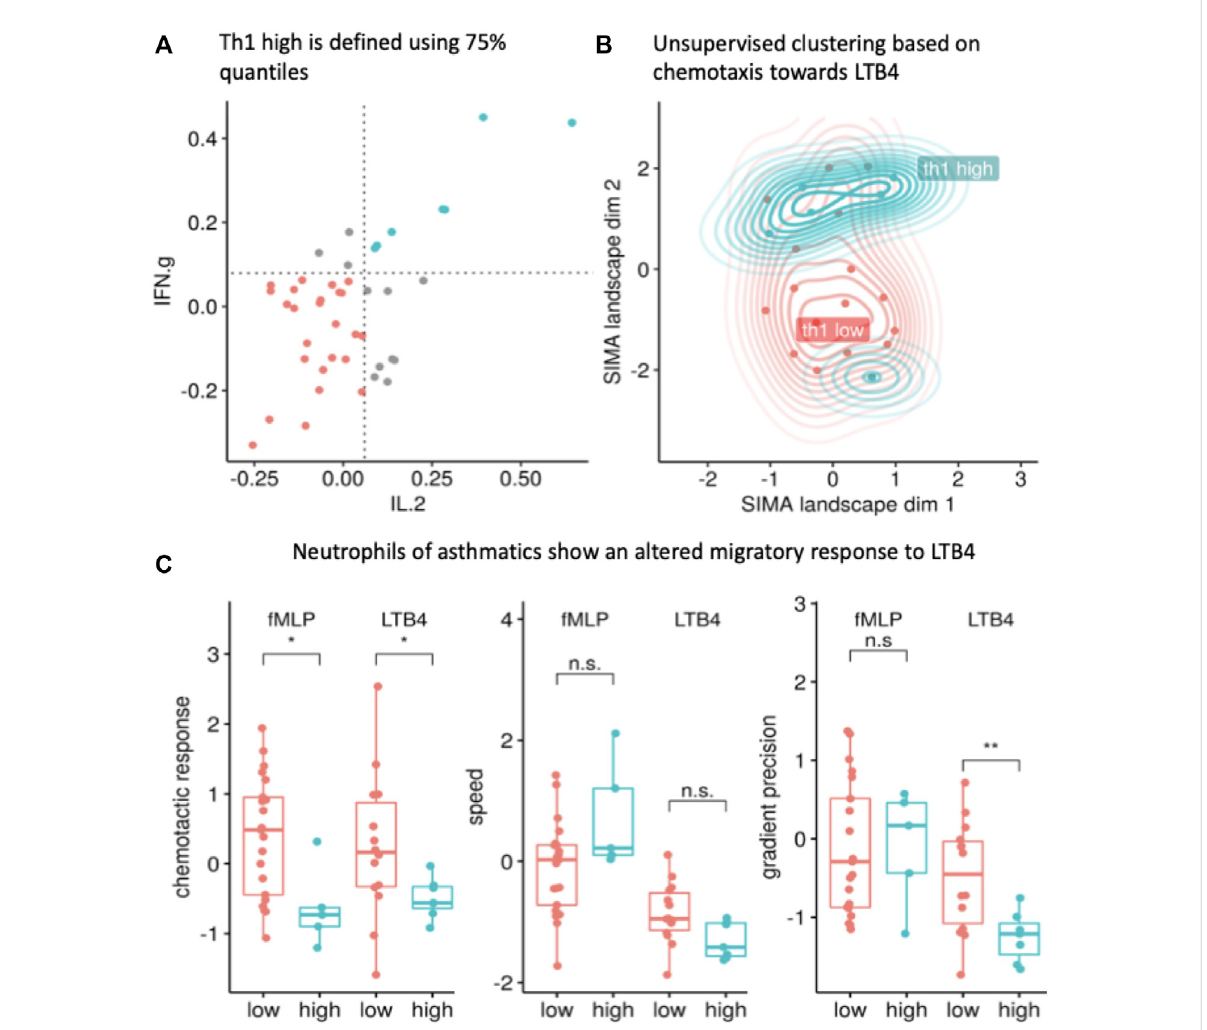
FIGURE 4 The Th1-high asthma phenotype(blue)correspondsto aunique chemotaxis pattern. (A) The Th1-high phenotype (markedinblue) isde fi nedas apatient with interleukin 2 (IL2) and interferon gamma(IFN ɣ )levels above the > 75% quantile (quantilesare shown as dotted line; eachdot represents one patient and only patients with valid readouts for IL2 and IFN ɣ were included; Th1-low donors are presented in red). (B) The morphological dynamics are projected into the SiMA landscape and show a cluster of Th1-high asthma patients. The 2D embedding was calculated using a UMAP projection of all morphological and dynamic features based on chemotaxis experiments towards LTB 4 with IL2 and IFN ɣ measurements ( n = 20 with 13 Th1-low and 7 Th1-high). (C) The migratory response (z-value) of Th1-high NGs in a LTB 4 gradient shows a signi fi cant difference compared to neutrophils isolated from Th1-low donors (reduced chemotactic response (z-value), p < 0.01, t -test) and reduced gradient precision (z-value, p < 0.01, t -test). The migration towards fMLP shows a similar effect for the chemotactic response (z-value, p < 0.05, t